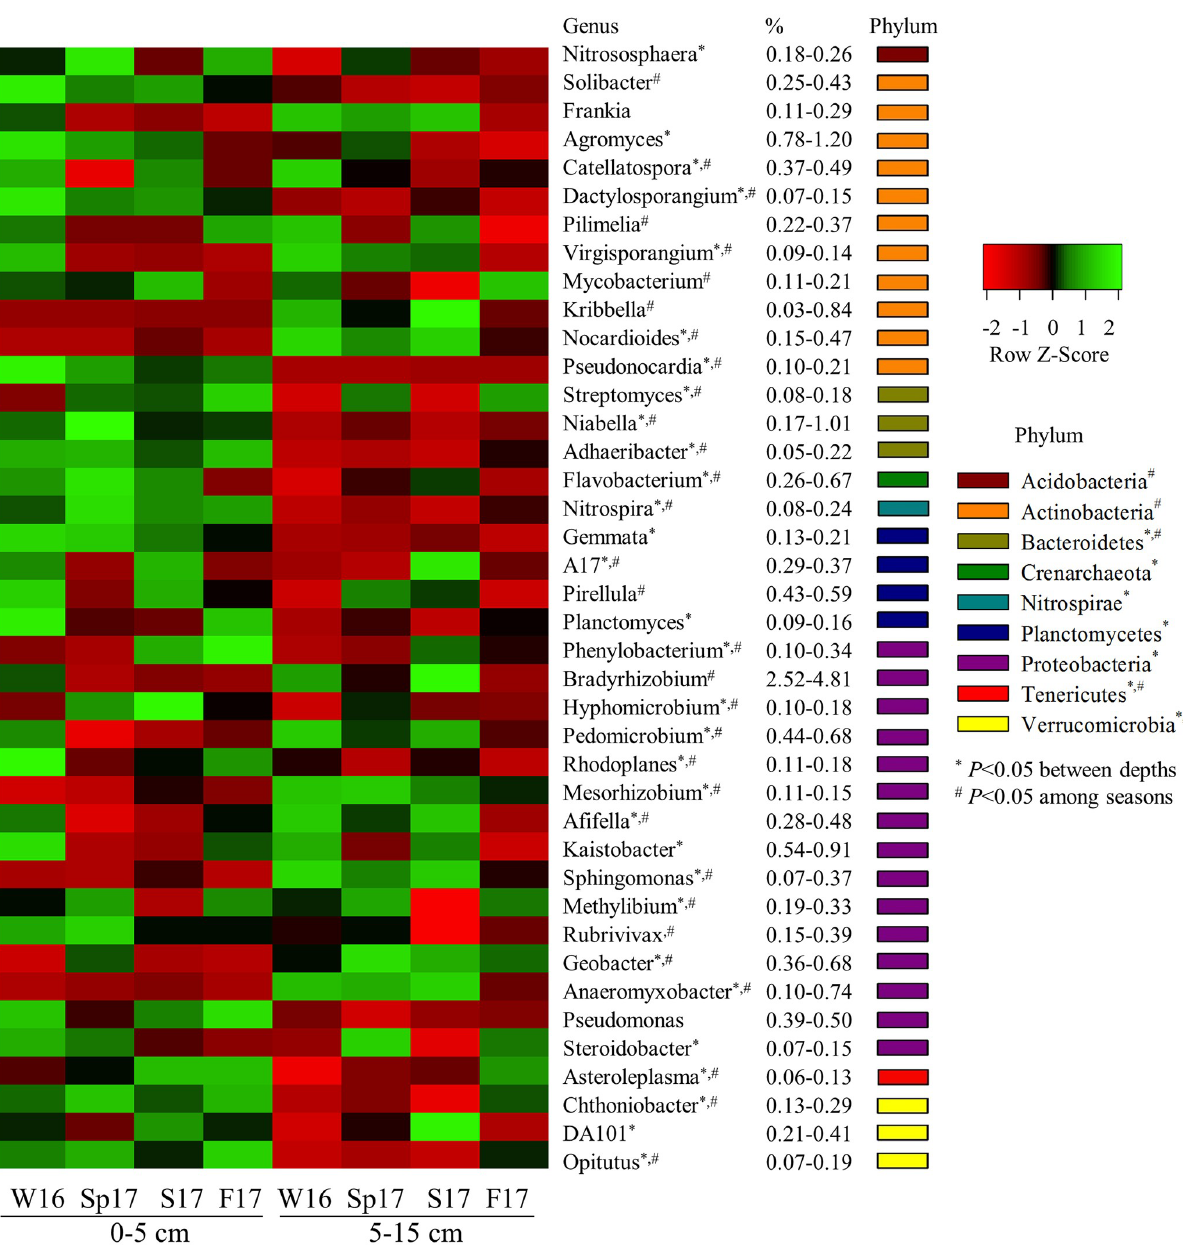
Fig 6. A heat map of relative abundance of bacterial/archaeal dominant taxonomic groups at genus level (average abundances > 0.1%) that were significantly variable between two soil depths (0–5 and 5–15 cm) and over four sampling seasons (Winter 2016, Spring, Summer, and Fall 2017). Asterisks indicate significant difference between two soil depths (0–5 and 5–15 cm) at α = 0.05. Number signs indicate significant difference over four sampling seasons (Winter 2016, Spring, Summer, and Fall 2017) at α =